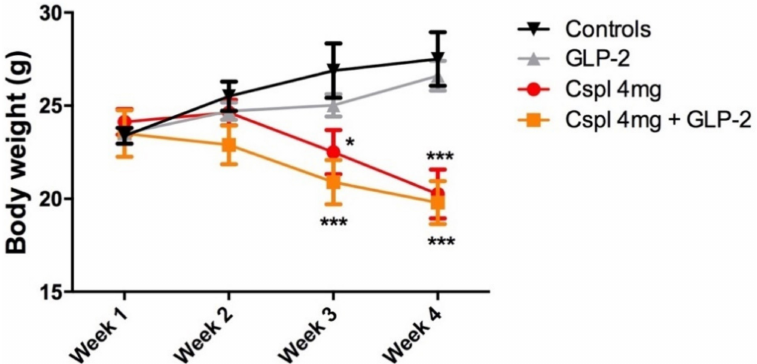
Figure 1. Time course of the bodyweight growth during 4 weeks of treatment. The mice were weighed every Thursday before the cisplatin injection. Data are expressed as mean ± SEM. Two-way ANOVA test, post hoc Bonferroni’s test. *** ( p < 0.001), * ( p < 0.05) vs. controls. n = 4–6 for each